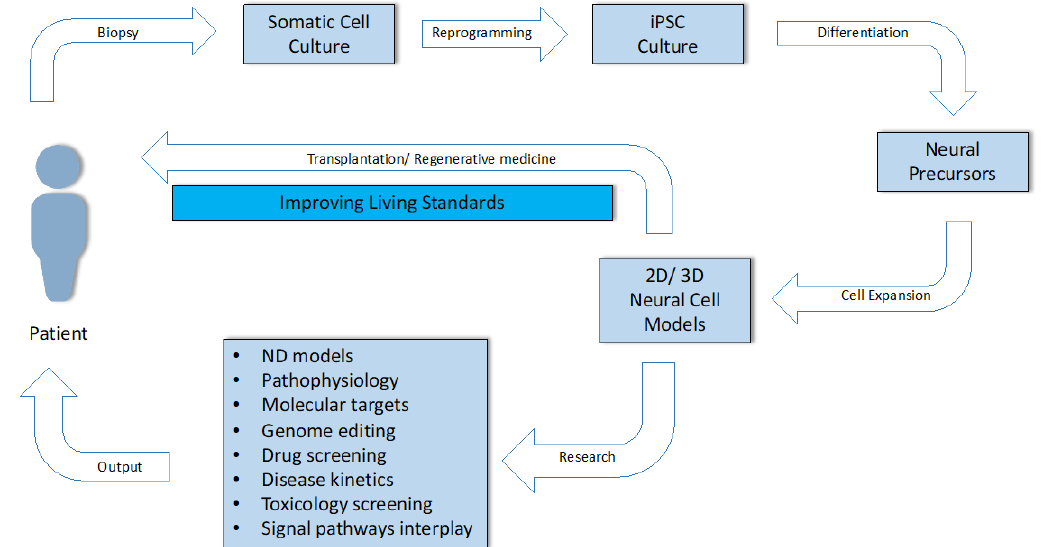
Figure 4. Use of the somatic cells of an adult patient through the stages of culturing, reprogramming, differentiation, biological characterization, in vitro modeling of disease, drug testing, and the possibility of their use in clinical practice and personalized regenerative medicine.